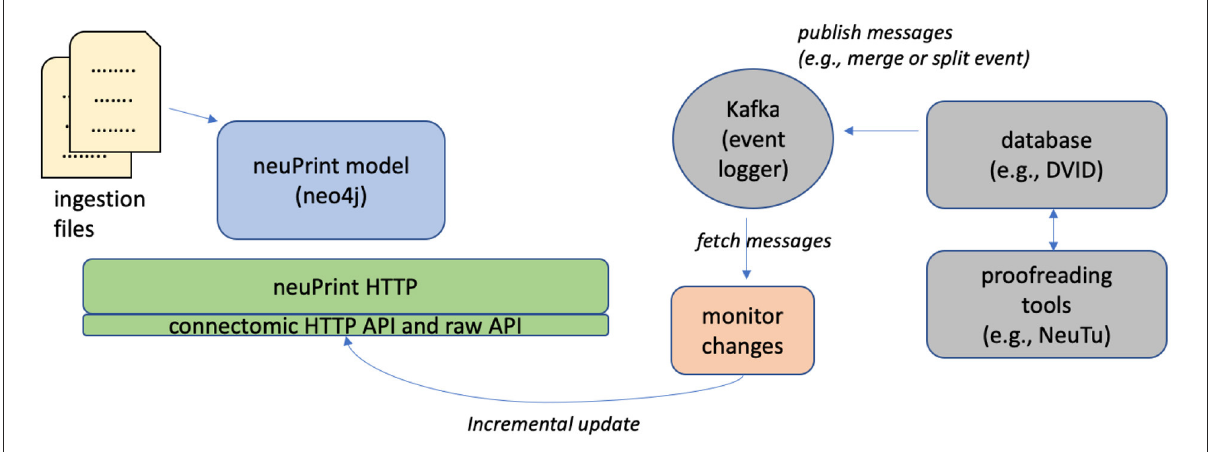
FIGURE4 Initializing and updating the neuPrint graph data. The database is initialized by ingesting data via a series of CSV files. To update the data incrementally, a service monitors dataset changes recorded in Apache Kafka and makes incremental updates through neuPrintHTTP.